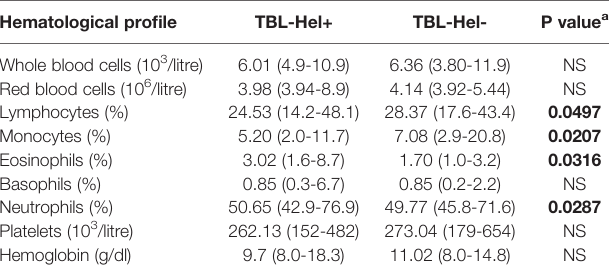
TABLE 2 | Hematological pro fi le of the study